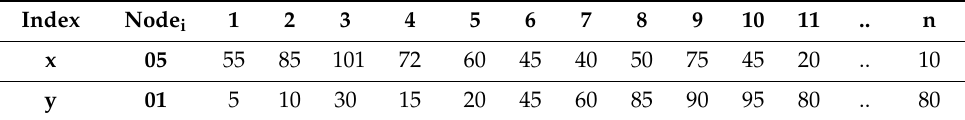
Table 5. A sample of representative positions of the sensor nodes.